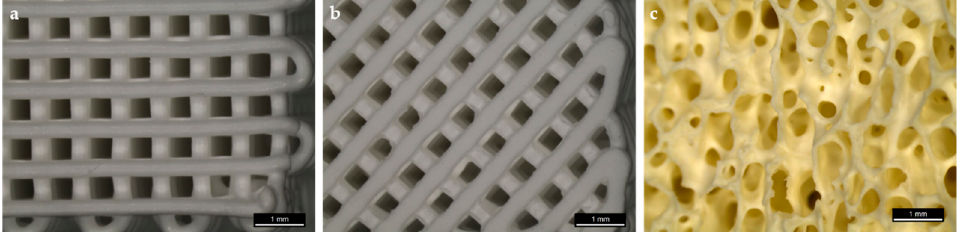
Figure 6. Three dimensional (3D) plotted scaffold with defined pore size (0.49 mm) and strand distance (0.82 mm): ( a ) strand orientation 90° related to edge, ( b ) strand orientation 45° related to edge, ( c ) BioOss ® ; scale bars: 1 mm.